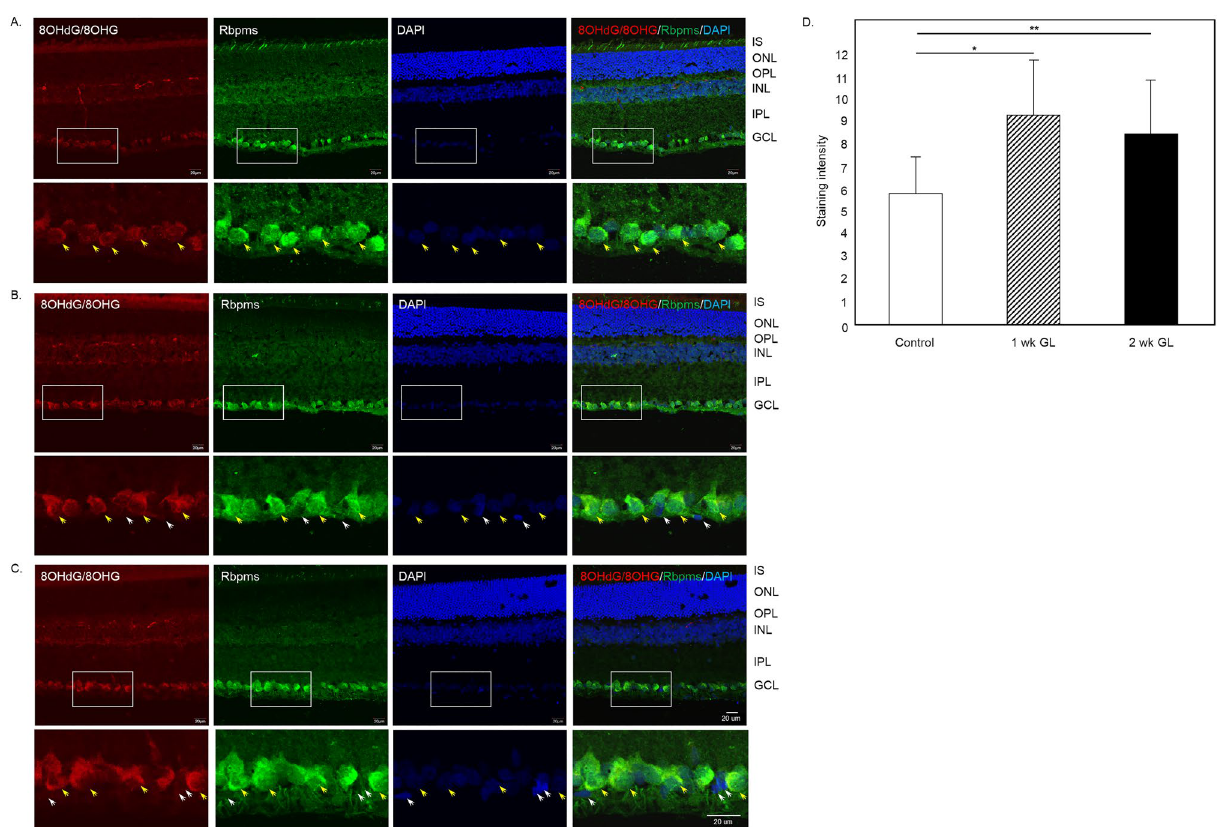
Figure 2. DNA/RNA oxidative damage in retinas of experimental glaucoma model. Immunostaining of retinal sections with monoclonal antibodies against for 8OHdG/8OHG, markers of oxidative damage to DNA and RNA, showed a strong reaction with cells within GCL of control ( A ) and glaucomatous retinas 1 ( B ) and 2 ( C ) weeks after IOP elevation. These 8OHdG/8OHG-positive cells were RGCs as they were stained with an RGC marker Rbpms (yellow arrows). Rbpms-negative cells in the GCL were also negative or poorly stained for 8OHdG/8OHG (white arrows). Although RGCs in both control ( A ) and hypertensive retinas ( B and C ) were 8OHdG/8OHG-positive, it appears that the intensity of staining in glaucomatous retinas is higher than in the controls. DAPI was used as a nuclear counterstain. ( D ) Quantitative analysis of RGC immunoflorescence in control and experimental animals 1 week and 2 weeks after IOP elevation. Ninety six RGCs from each group (n = 4 per group) were analyzed. Staining intensities in control, 1 and 2 weeks glaucomatous retinas were 5.56 ± 1.74, 9.24 ± 2.60 and 8.22 ± 2.69, respectively. The difference in RGC staining intensity between experimental and control retinas was statistically significant: * P = 4.68252E-20 and ** P = 2.50218E-12. Data are presented as the mean ± SD. IS, photoreceptor inner segments; ONL, outer nuclear layer; OPL, outer plexiform layer; INL, inner nuclear layer; IPL, inner plexiform layer; GCL, ganglion cell layer; 1 wk GL, 1 week glaucoma; 2 wk GL, 2 weeks